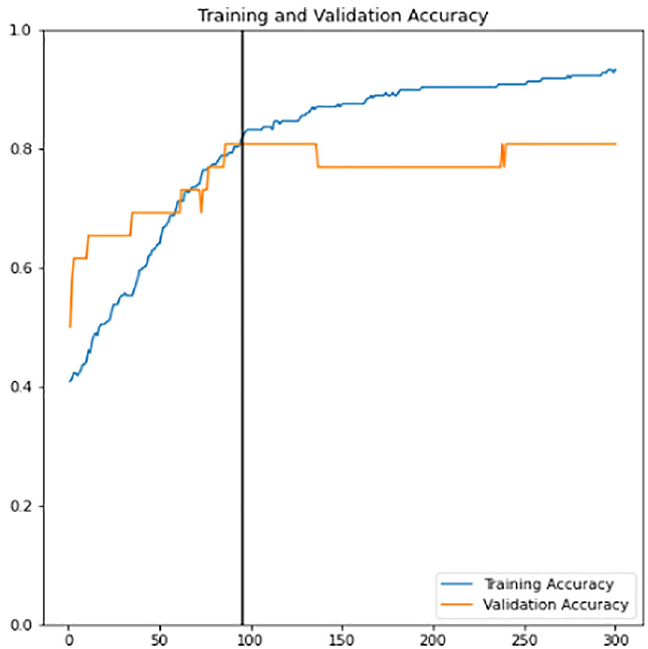
Figure 9. Training learning curve of accuracy for training and validation sets of newly defined